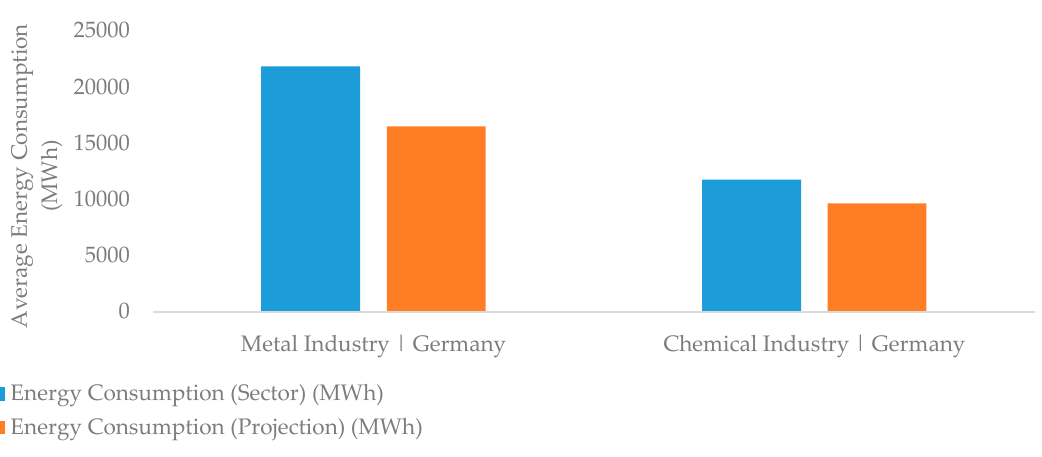
(b) Figure 9. Potentials savings in energy consumption for each approached industrial sector in Portugal. ( a ) paper & pulp industry, ( b ) food industry. The metal industries in the UK and Norway are represented by CS3 and CS5, respectively. The potential savings in energy consumption are determined considering the average European Union levels, due to, as previously mentioned, the inexistence of data namely of the number of enterprises